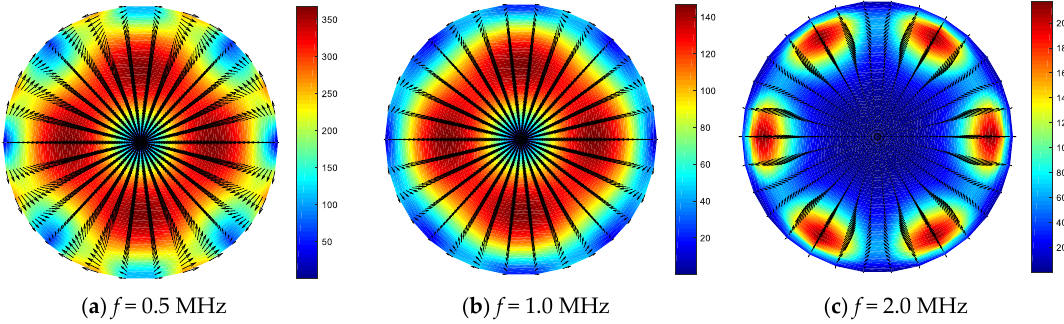
Figure 9. F d (2,1) Poynting vector at each frequency.